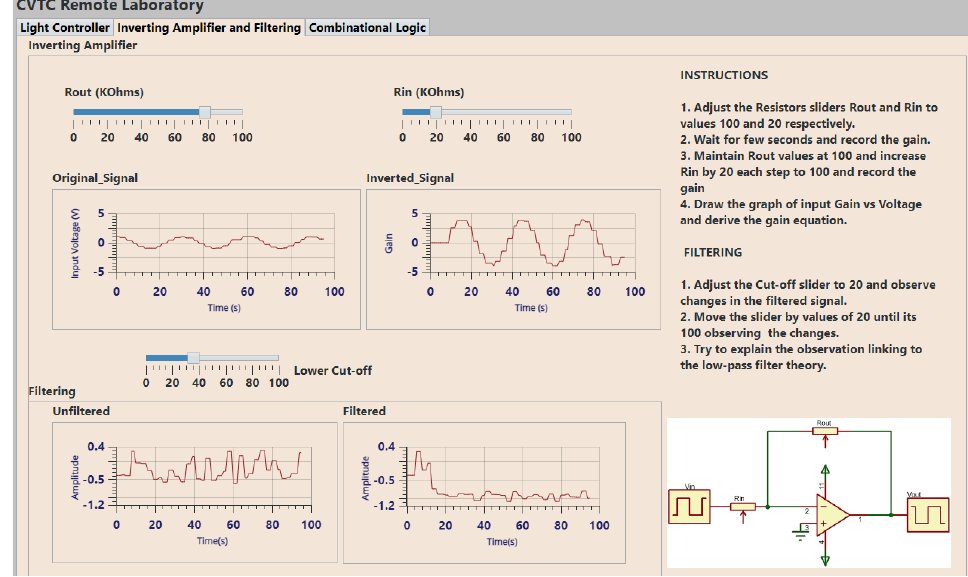
Figure 12. Inverting Amplifier and Signal filtering lab